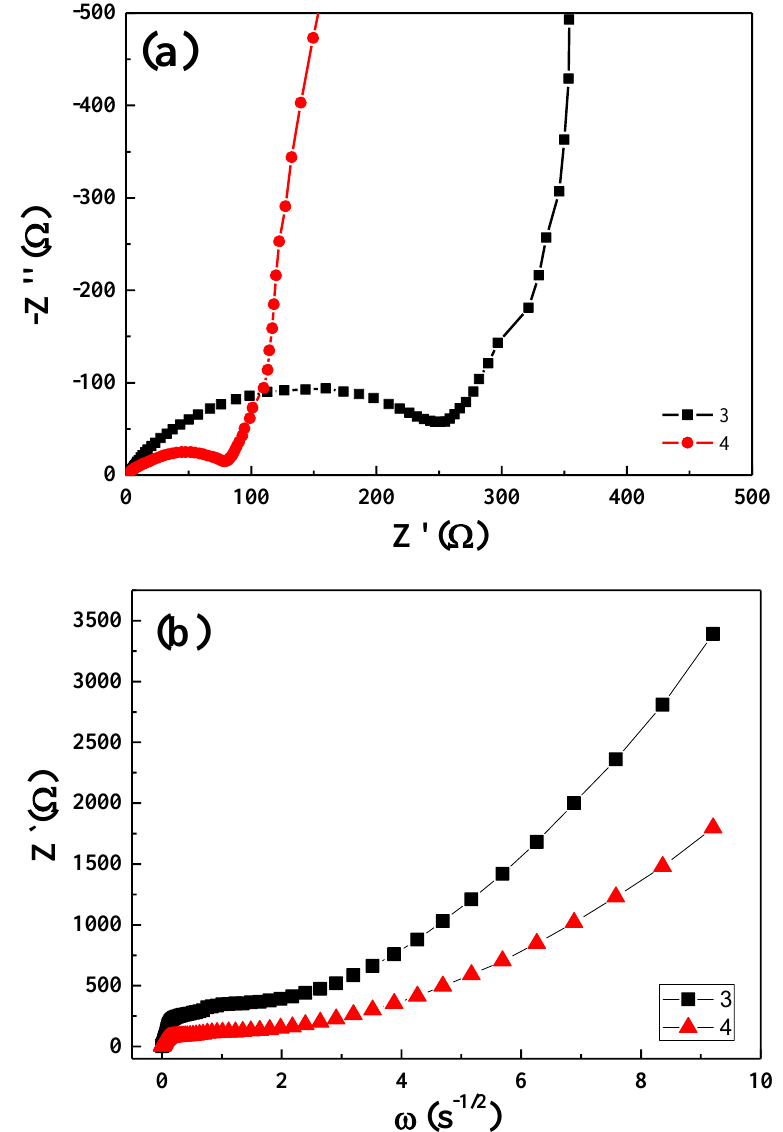
Figure 10. ( a ) The AC impedance of complex 3 and complex 4 ; ( b ) diagram of Z’ and ω − 1/2 . The slope of diagram is Warburg impedance coefficient.